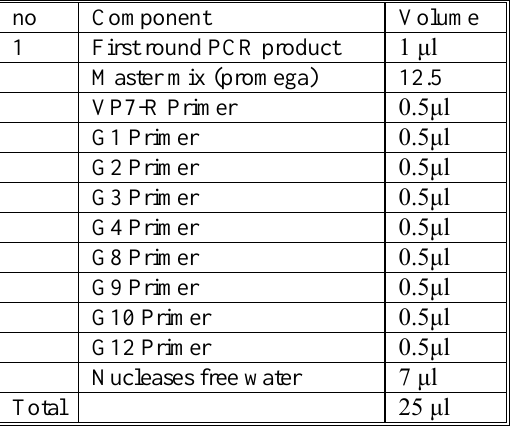
Table 3. Reaction mixture components for rotavirus genotyping.